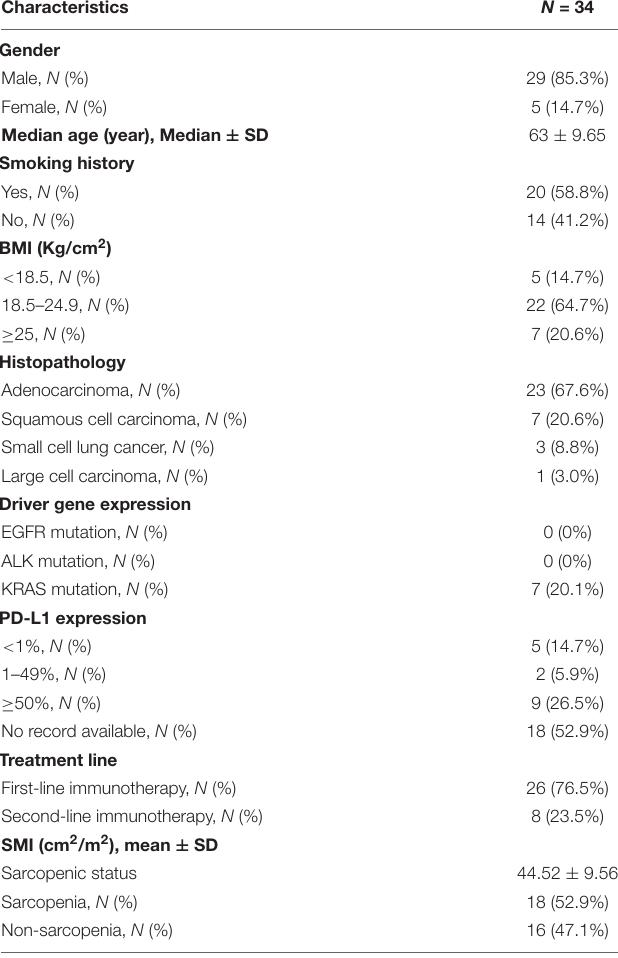
TABLE 1 | Baseline characteristics of the study